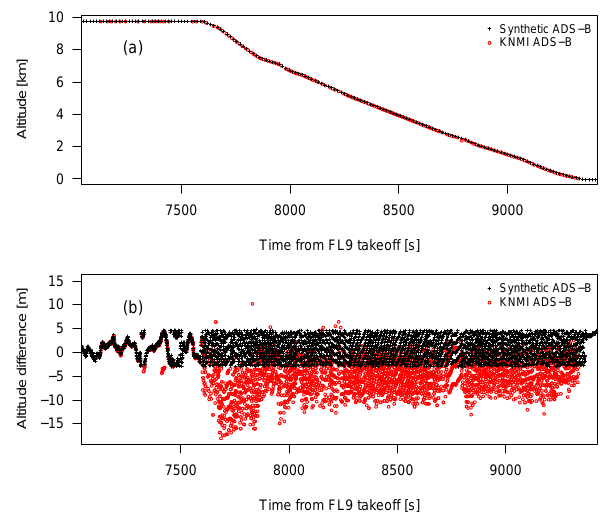
Figure 3. A comparison between the synthetic ADS-B data (black crosses) and reference KNMI ADS-B data (red circles) of (a) the altitude profile (note that for clarity 97% of the observations are not plotted here) and (b) the difference of the altitude with respect to the DELICAT reference